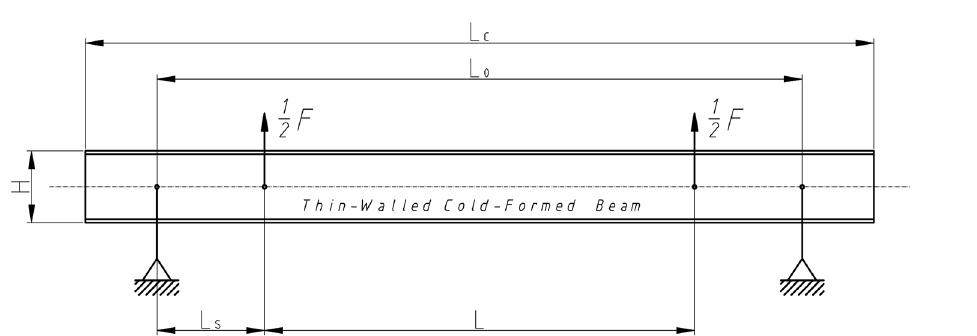
Figure 5. Load scheme and longitudinal dimensions of the